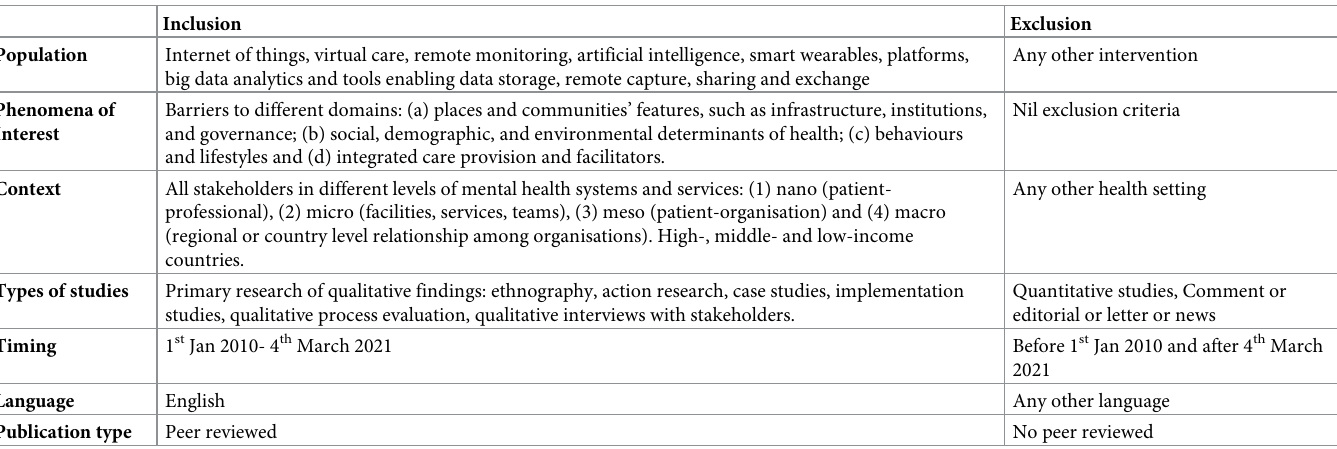
Table 1. Inclusion and exclusion